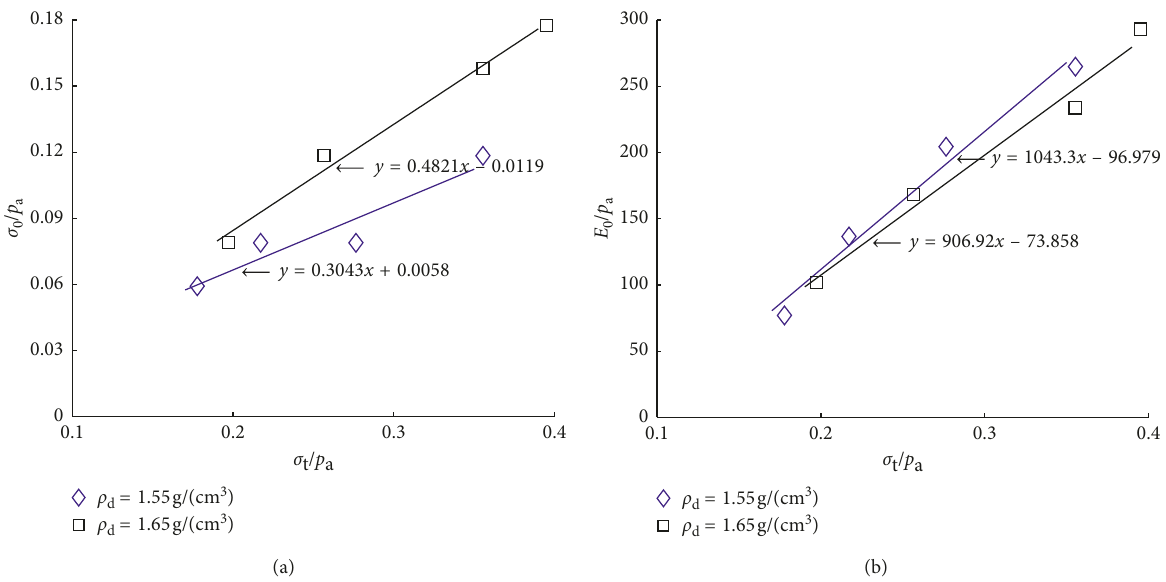
Figure 5: Relationships of the tensile strength with (a) yield limit σ